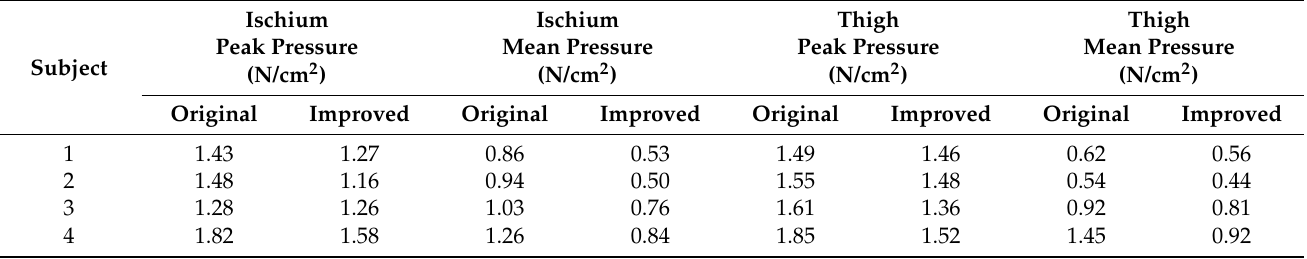
Table 6. Body pressure comfortable evaluation indexes of the original sponge and improved